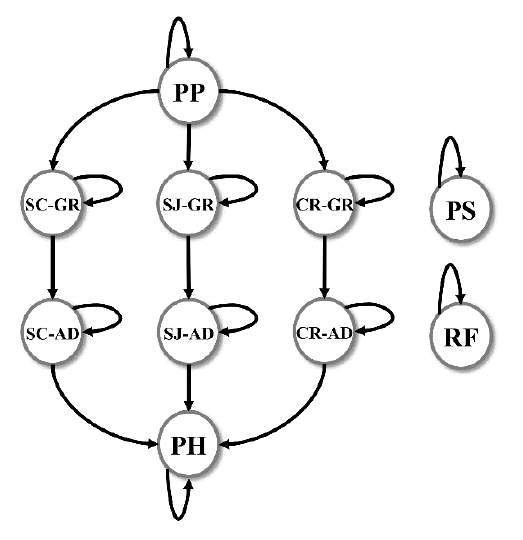
Figure 2: The underlying Markov